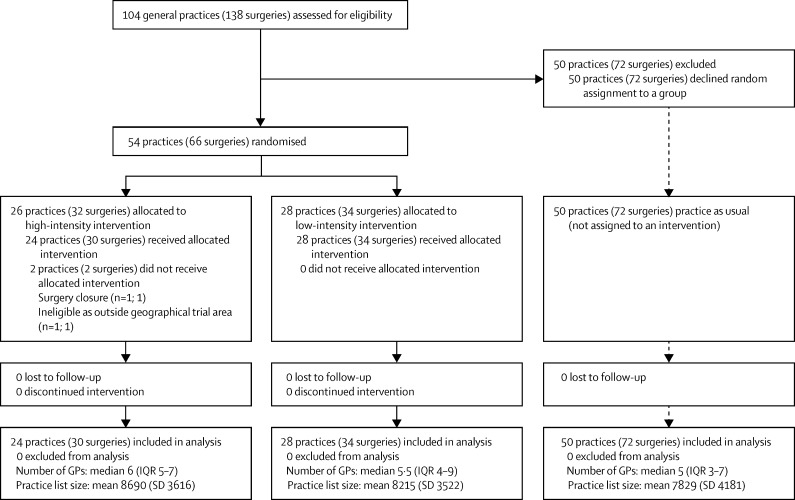
Trial profileGPs=general practitioners.